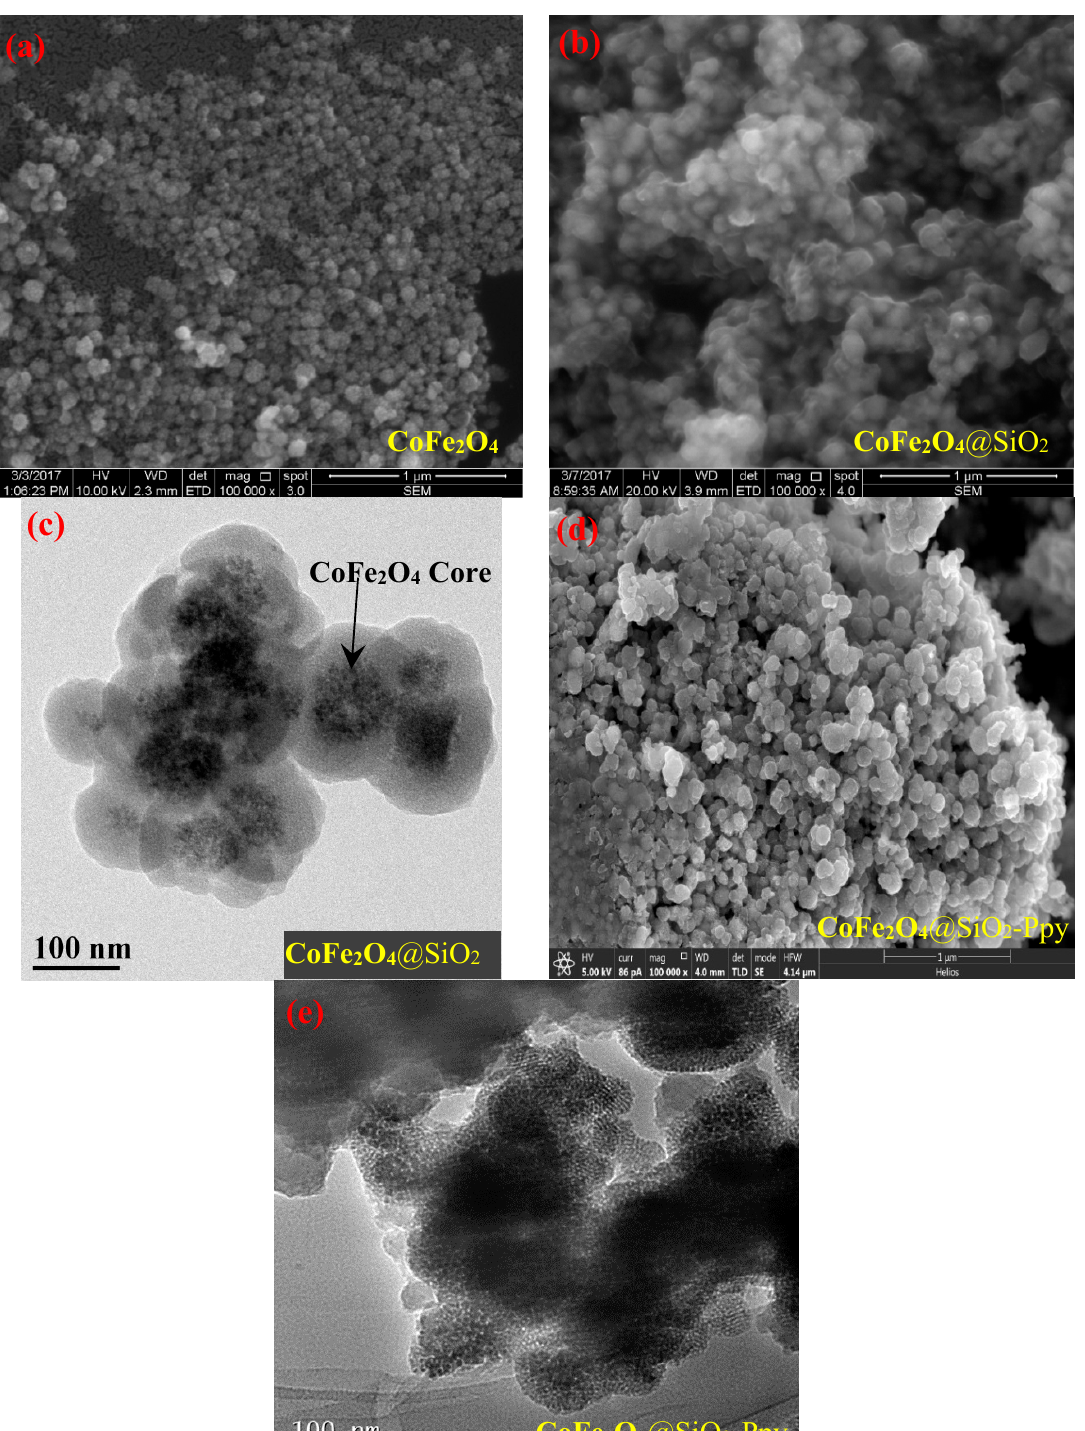
Figure 3. Scanning electron microscopy (SEM) of ( a , b ); Transmission electron microscopy (TEM) of ( c – e ) of the three as-prepared materials.